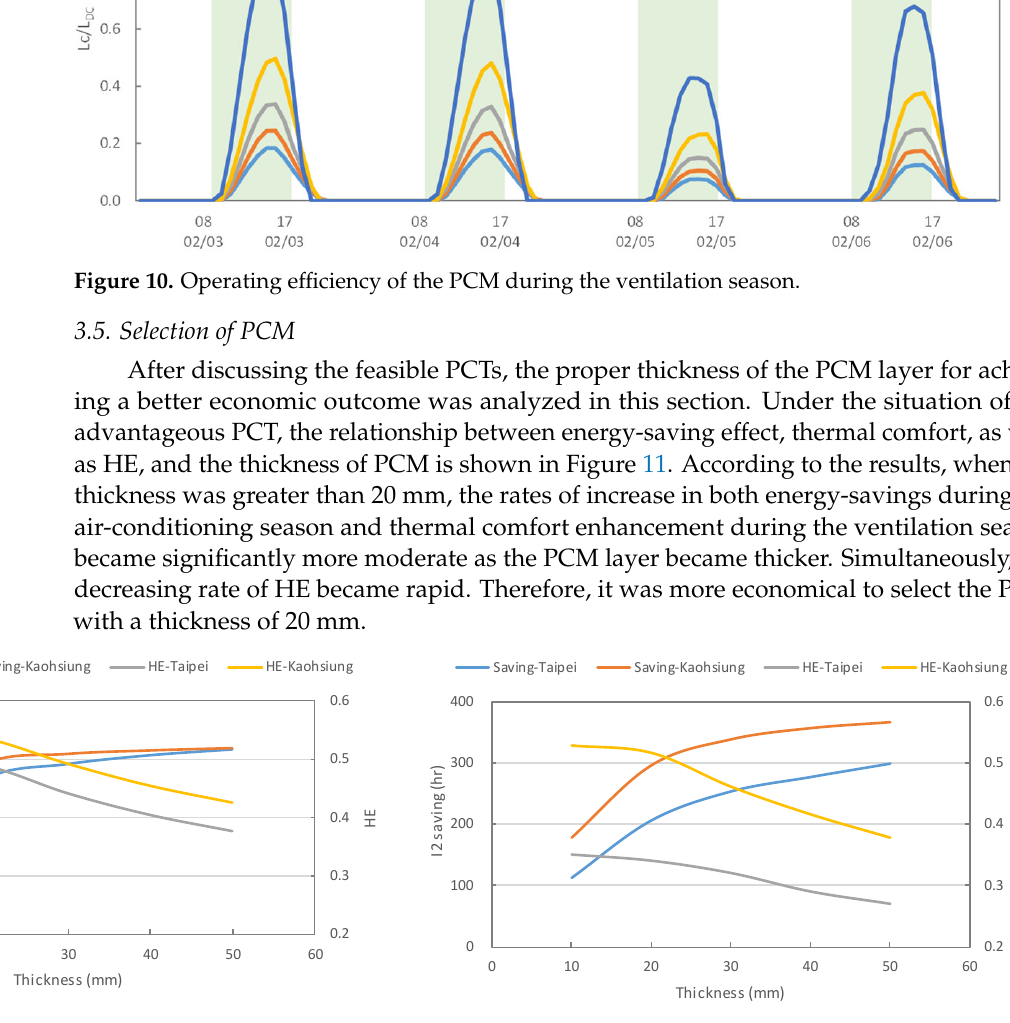
Figure 11. The energy-saving and thermal comfort efficacy of different thicknesses of PCM layers under the beneficial PCT.